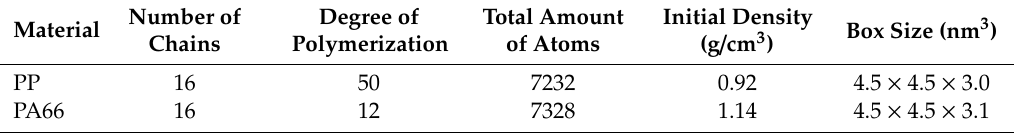
Table 1. Main parameters of polypropylene (PP) and polyamide 66 (PA66) atomistic models.